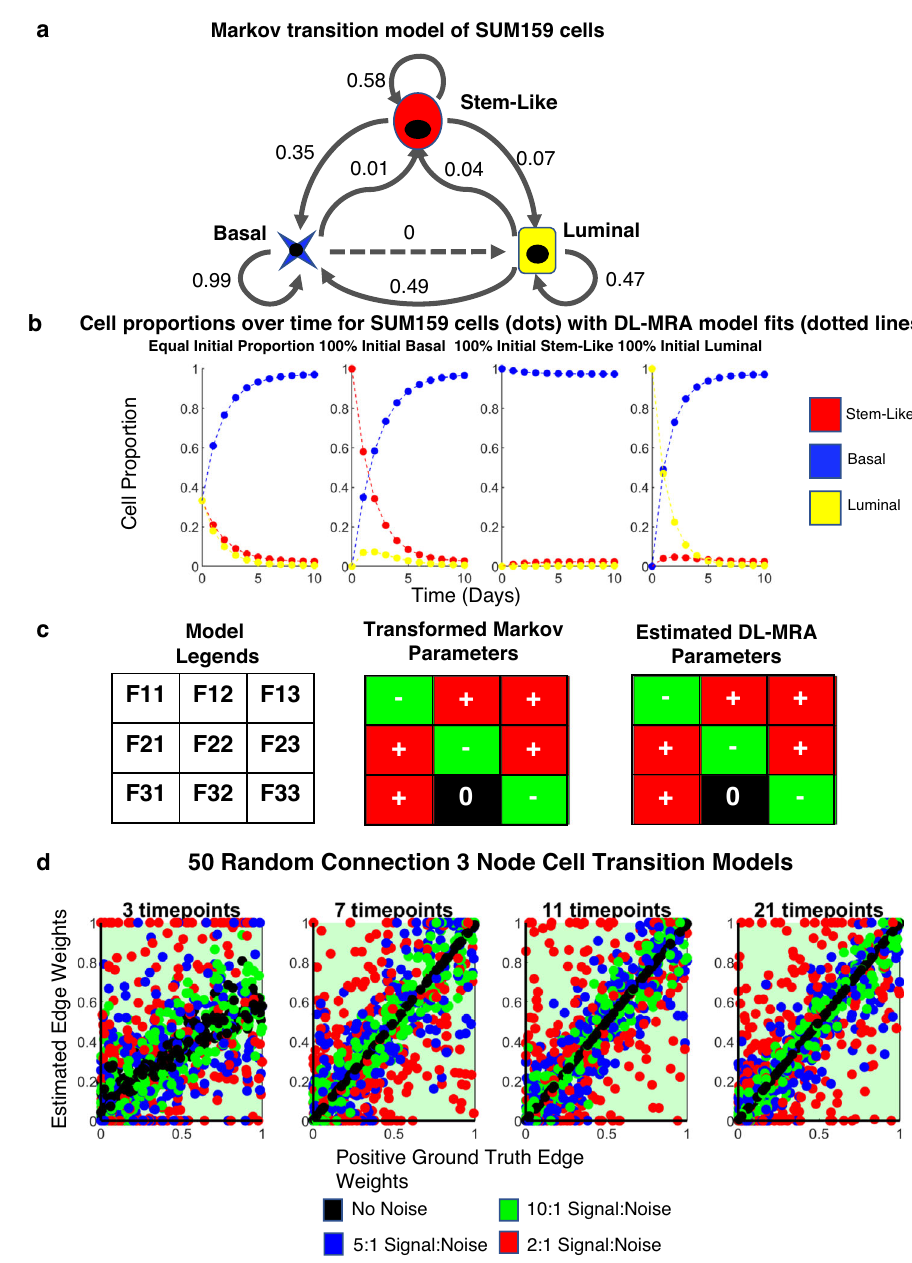
Fig. 3 Application to cell state transition networks. a Markov transition model of SUM159 cell states. b Cell proportions over time for SUM159 cells using Markov transition parameters (dots), starting at different initial proportions and respective DL-MRA model fi ts (lines). c Parameters from DL-MRA estimates of SUM159 data are similarly classi fi ed as transformed Markov parameters (See Methods, Eqs. (29) and (30)). d Ground truth versus estimated edge weights across 50 random cell transition networks and noise levels for data from four different total timepoints